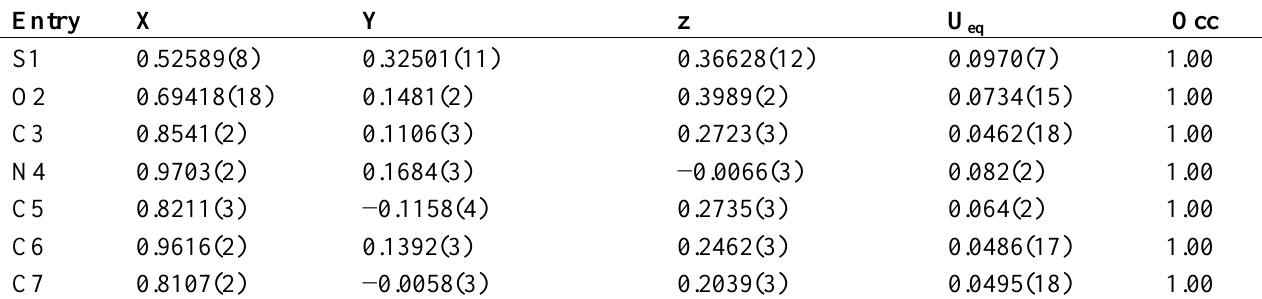
Table 1. Fractional atomic coordinates and equivalent isotropic thermal parameters (Å 2 ) of 2 , involving non-hydrogen